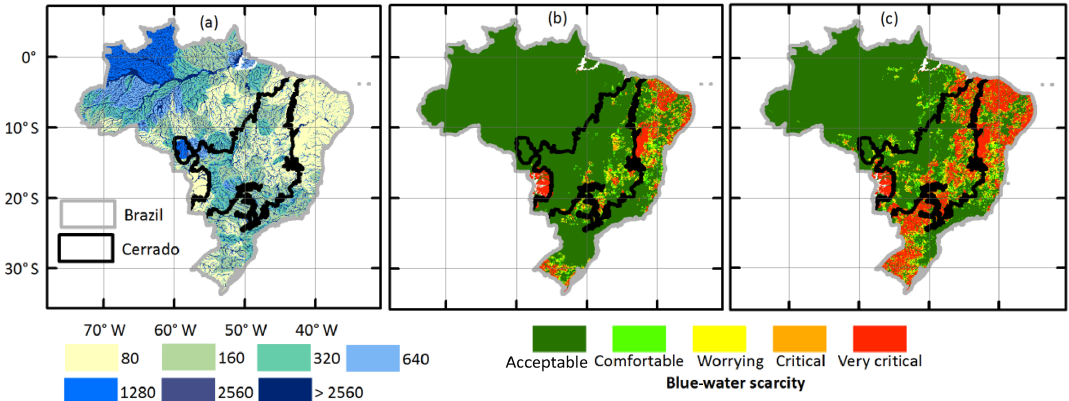
Figure 2. Water scarcity of 166844 catchments across Brazil. (a) Annual average water availability Q 95 . (b) Blue-water scarcity classifica- tion of irrigated areas. (c) Blue-water scarcity classification of rain-fed areas when irrigated. The black line delimits the Cerrado region.